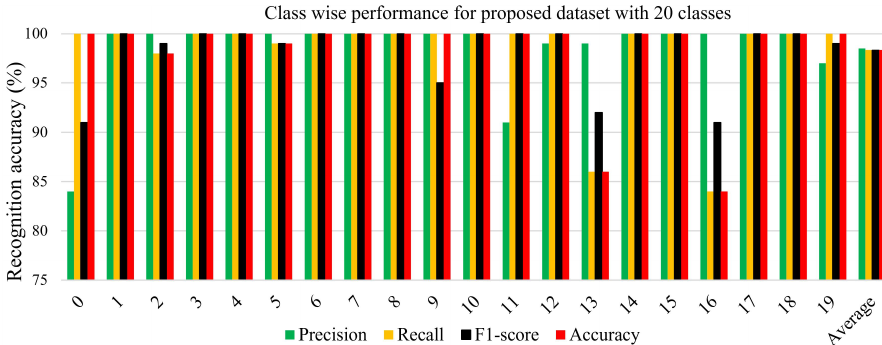
Figure 6. Precision, recall, F1-score and accuracy of the proposed dataset.